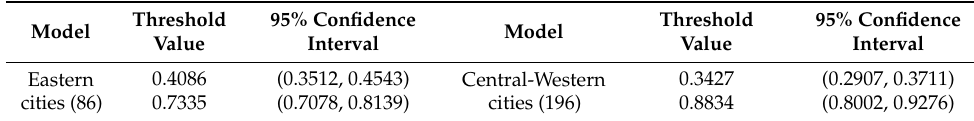
Table A3. The results of threshold effect of ER based on robust test model.